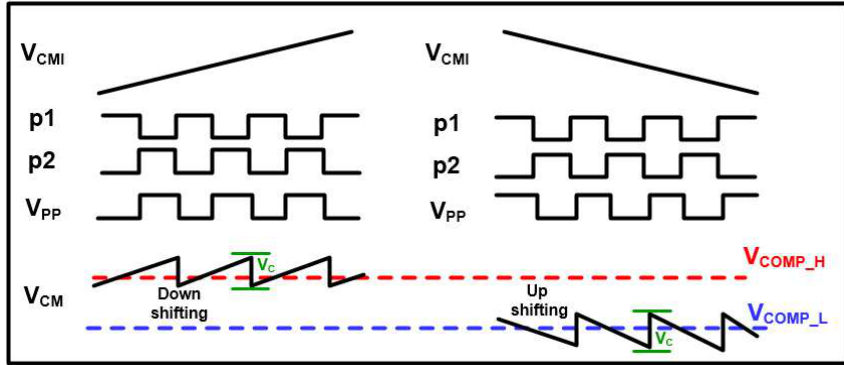
Figure 5. Timing diagram of the proposed CMCP.